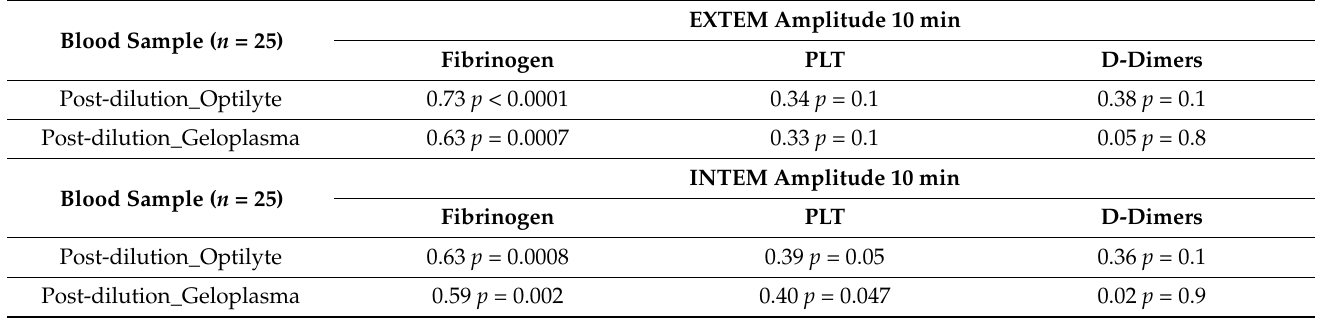
Table 4. Correlations between EXTEM and INTEM 10th minute clot amplitudes and standard